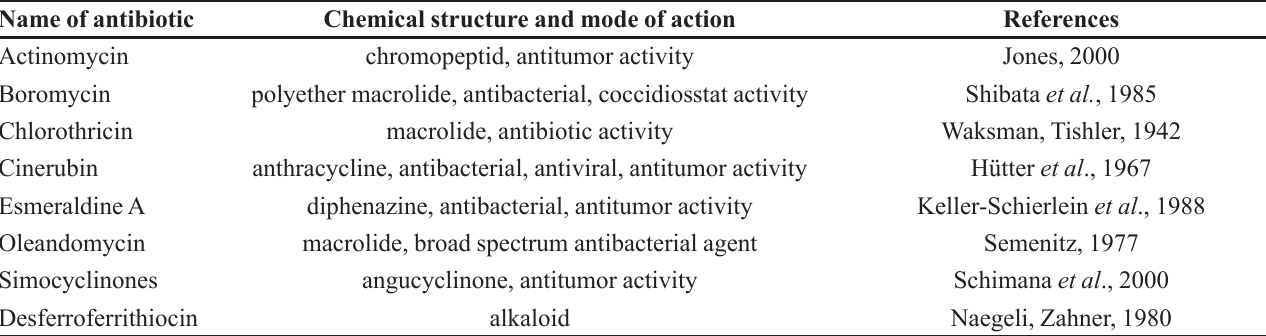
TABLE II - Chemical structure and mode of action of selected antibiotics produced by Streptomyces antibioticus Name of antibiotic